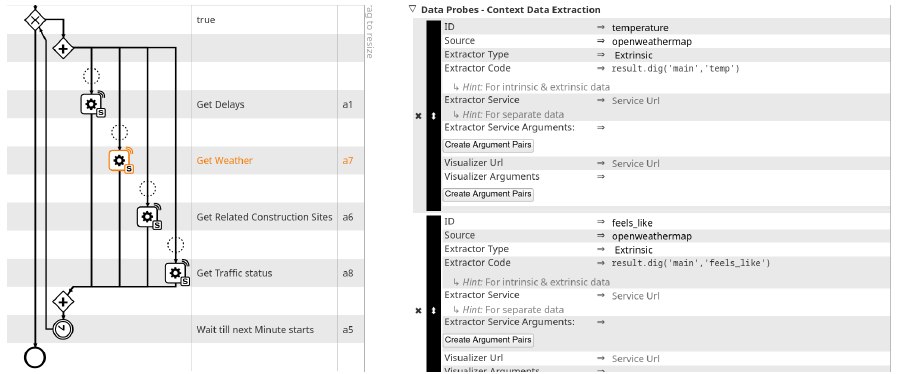
Figure 6. Data Probes for the “Get Weather”